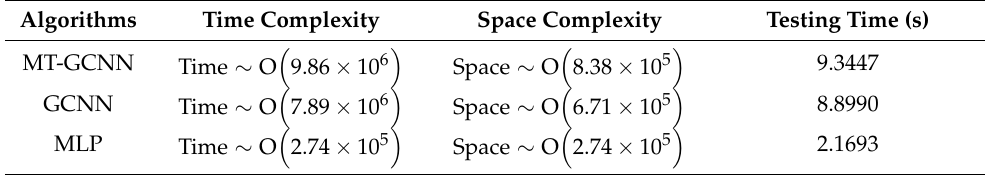
Table 2. The comparison of the mathematical complexity and testing time. Algorithms Time Complexity Space